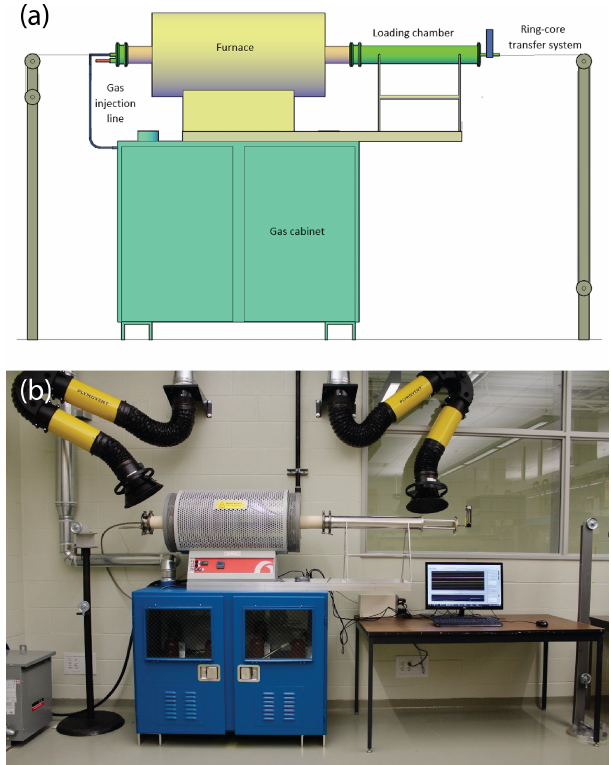
Figure 11. Diagram (a) and photograph (b) of the heat-treatment system, showing the loading chamber and wire pulley used for hot